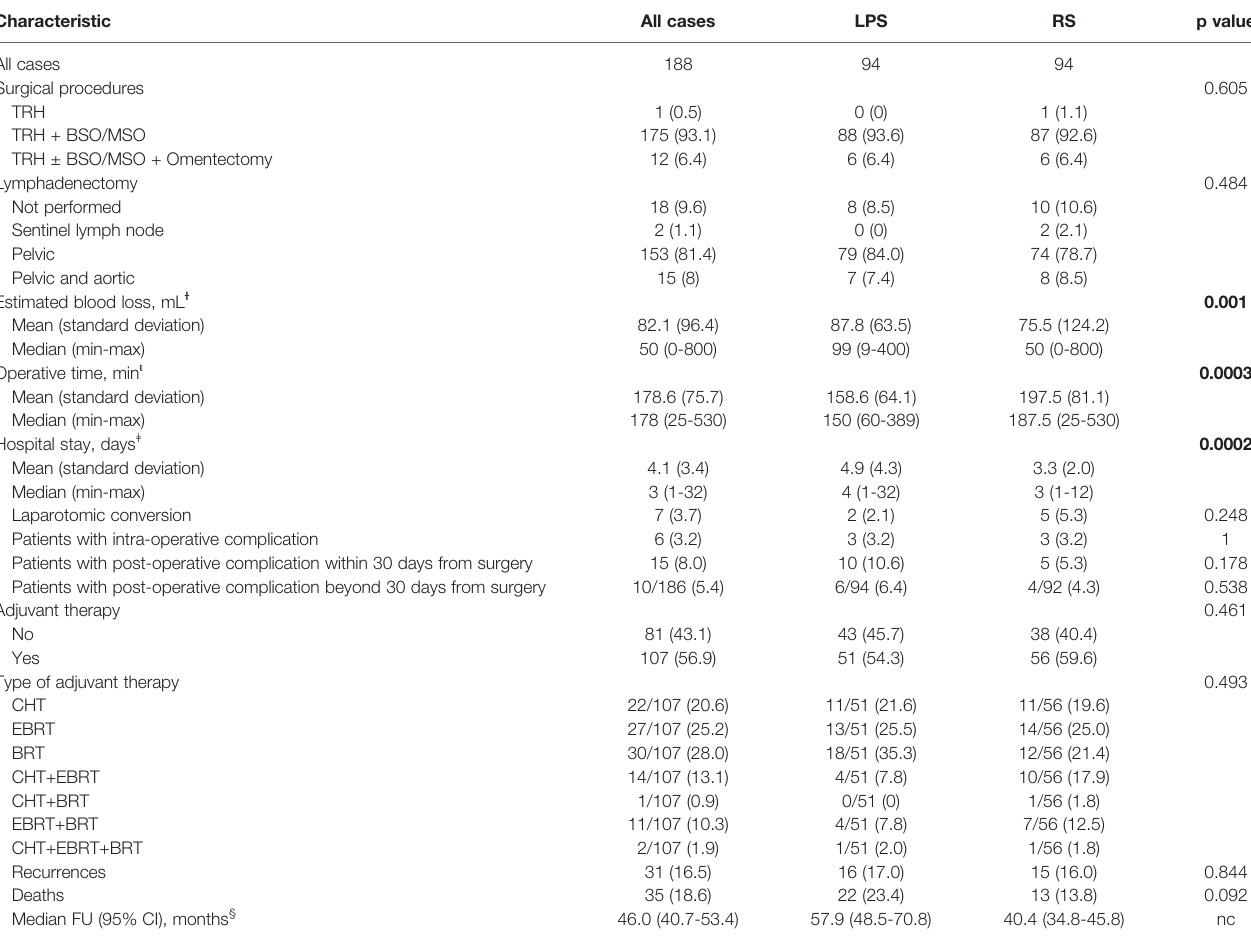
TABLE 4 | Surgical, adjuvant and follow up characteristics of 188 matched patients with endometrial cancer according to the type of surgery. Characteristic